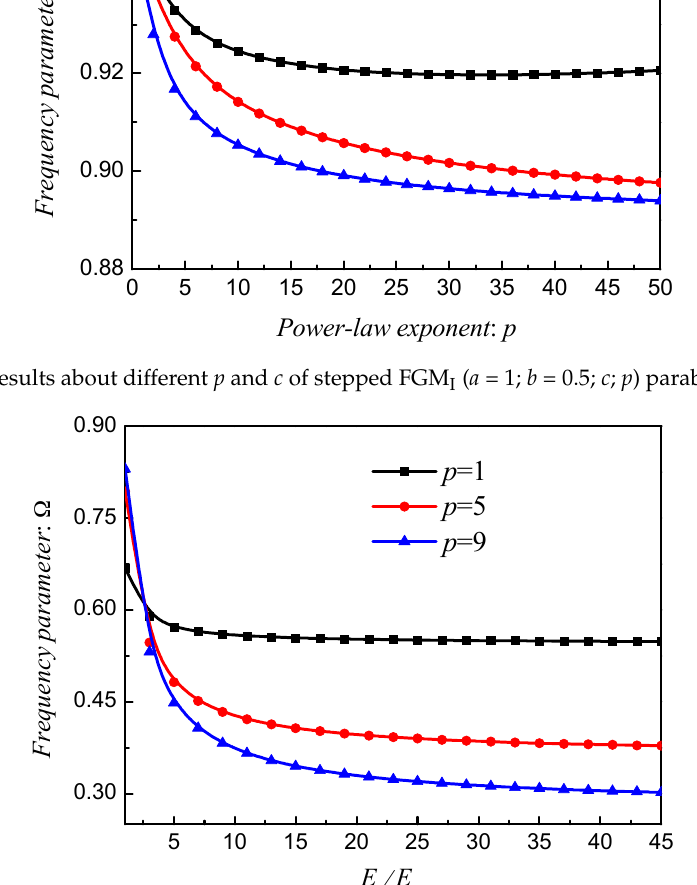
Figure 13. Results about different E c / E m and p of stepped FGM I ( a = 1; b = 0.5; c = 2; p ) paraboloidal shell.